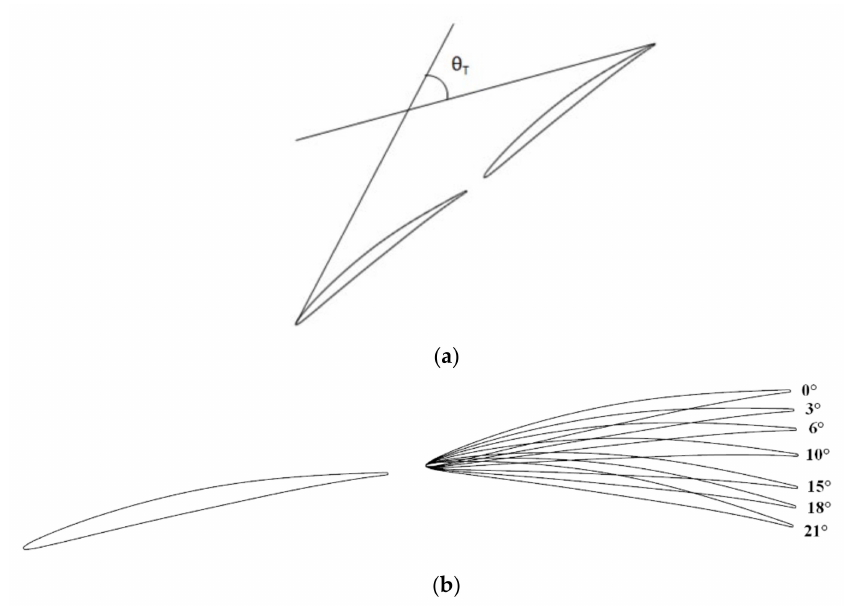
Figure 2. Diagram of total bending angle of tandem vane diffuser geometry. ( a ) Diagram of total bending angle of tandem vane diffuser and ( b ) Configuration of tandem vane diffuser for various total bending